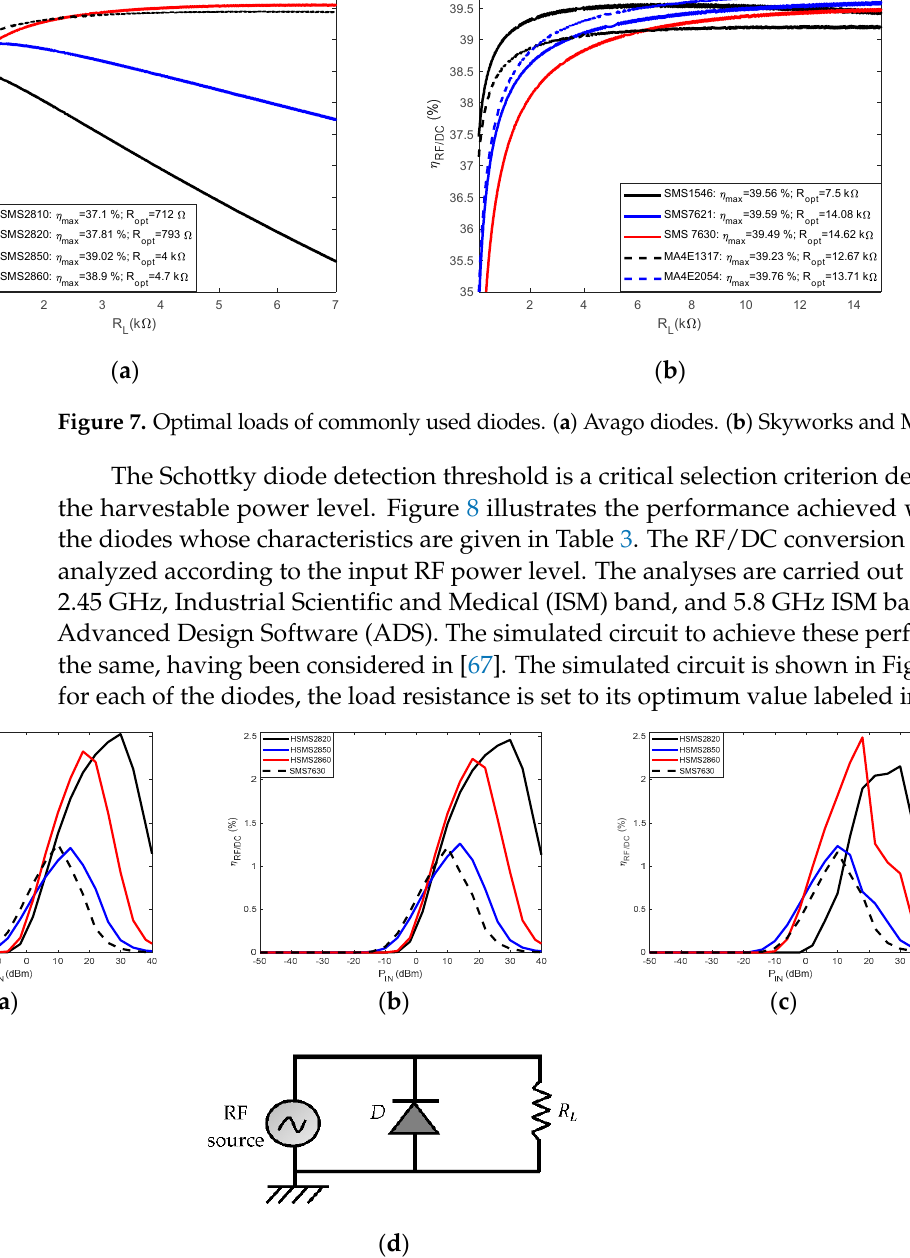
Figure 8. Comparison of the detection threshold of the diodes. ( a ) 900 MHz GSM band. ( b ). 2.45 GHz ISM band. ( c ) 5.8 GHz ISM band. ( d ). Schematic for the diode detection threshold.